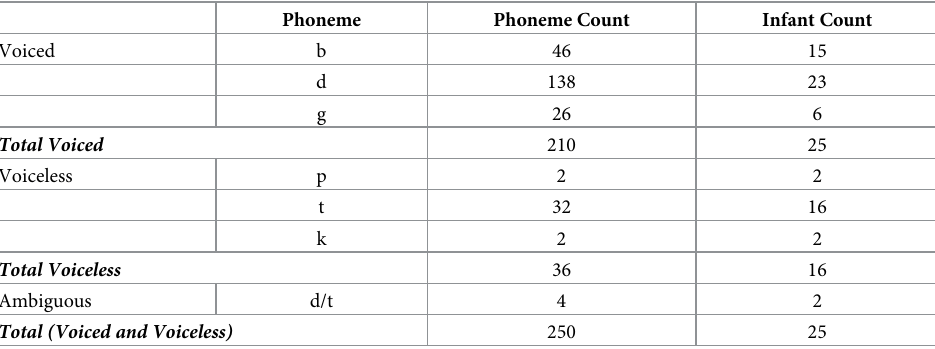
Table 1. Perception of stop consonants during initial calculation of voice onset